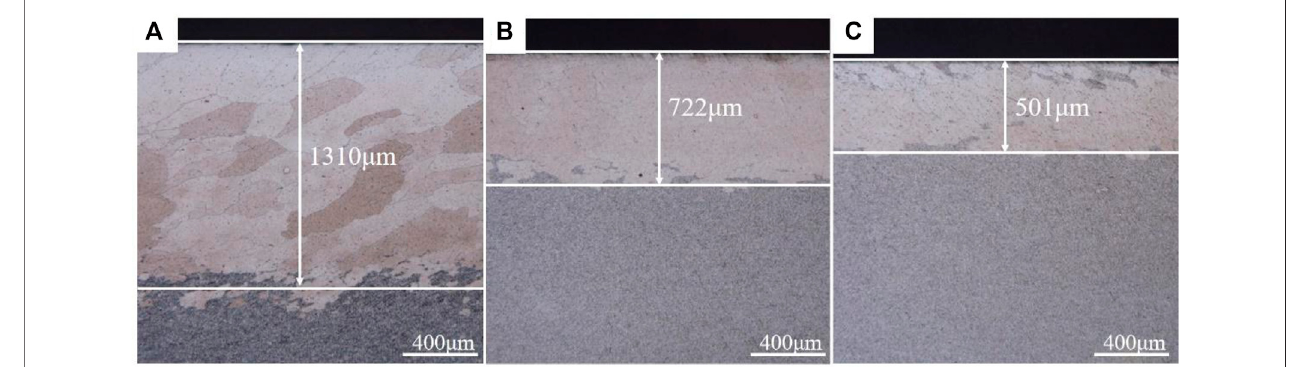
FIGURE 7 | OM diagram of the sample after annealing. (A) 1#, (B) 2#, (C)